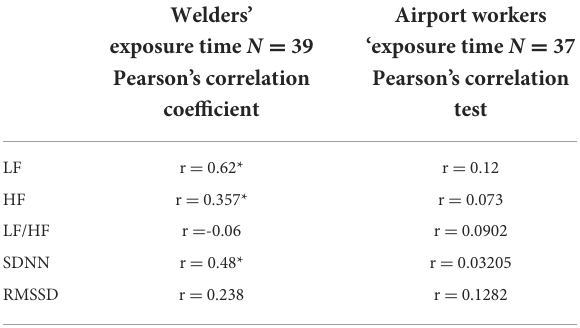
TABLE 6 Correlation between HRV value per hour and mean noise measurements per hour by group of workers with Pearson’s correlation test.